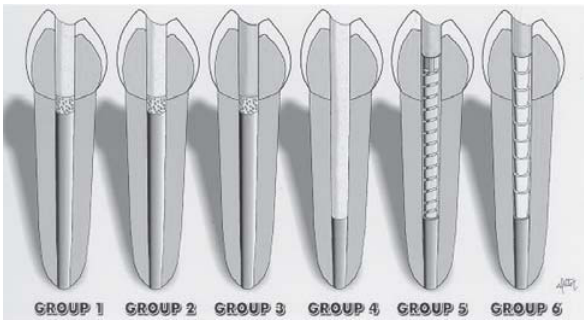
FIGURE 1- Schematic representation of the six